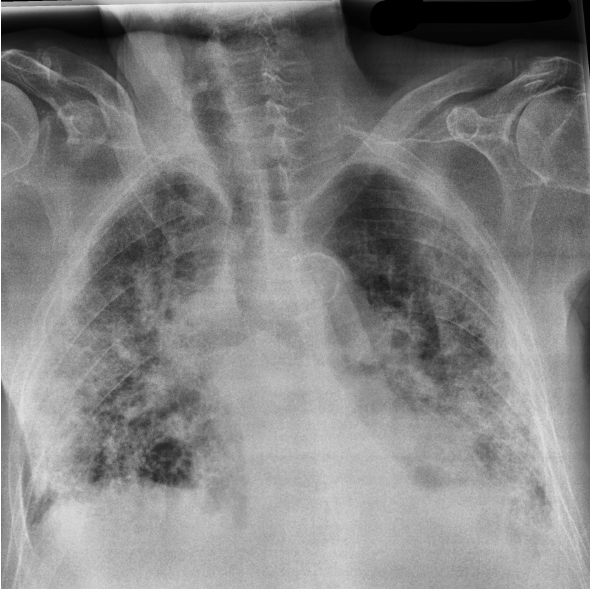
Figure 2. Pulmonary radiography of a person infected with COVID-19.